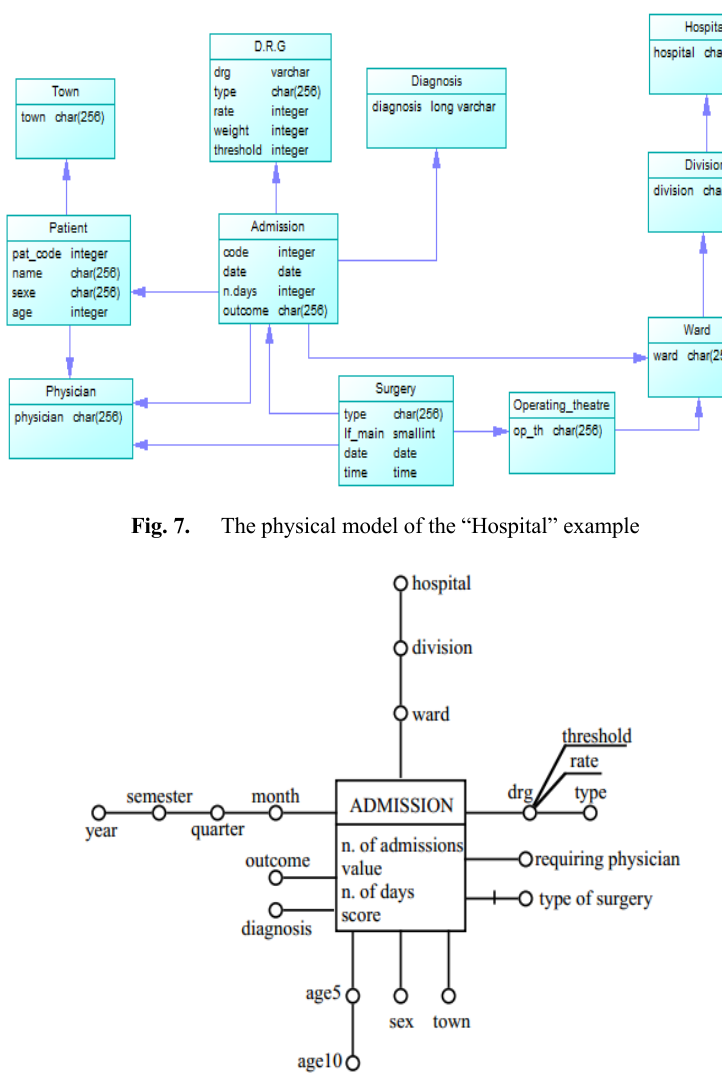
Fig. 8. The multidimensional model of the “Hospital”